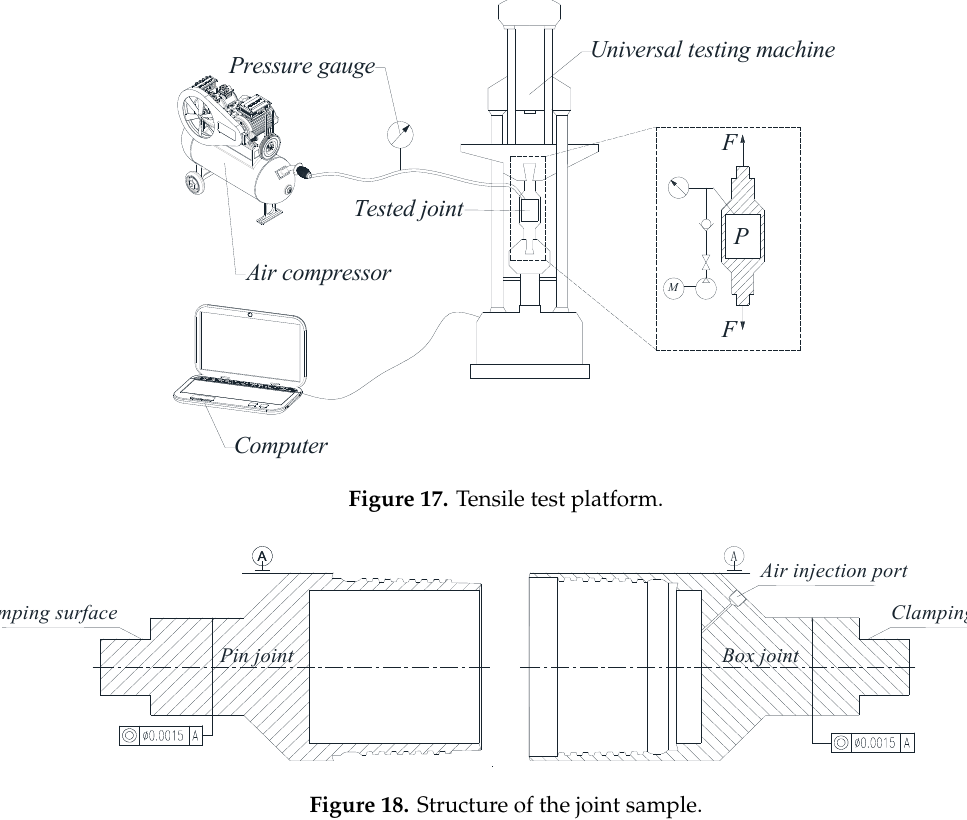
Figure 18. Structure of the joint sample.